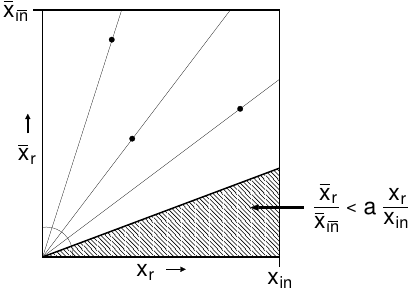
Figure 4 . Phase space for the collinear subtraction term. The lines with a dot correspond to final-state collinear singularities, and the vertical and horizontal axis correspond to initial-state collinear singularities. The region near x r = ¯ x r = 0 is the soft